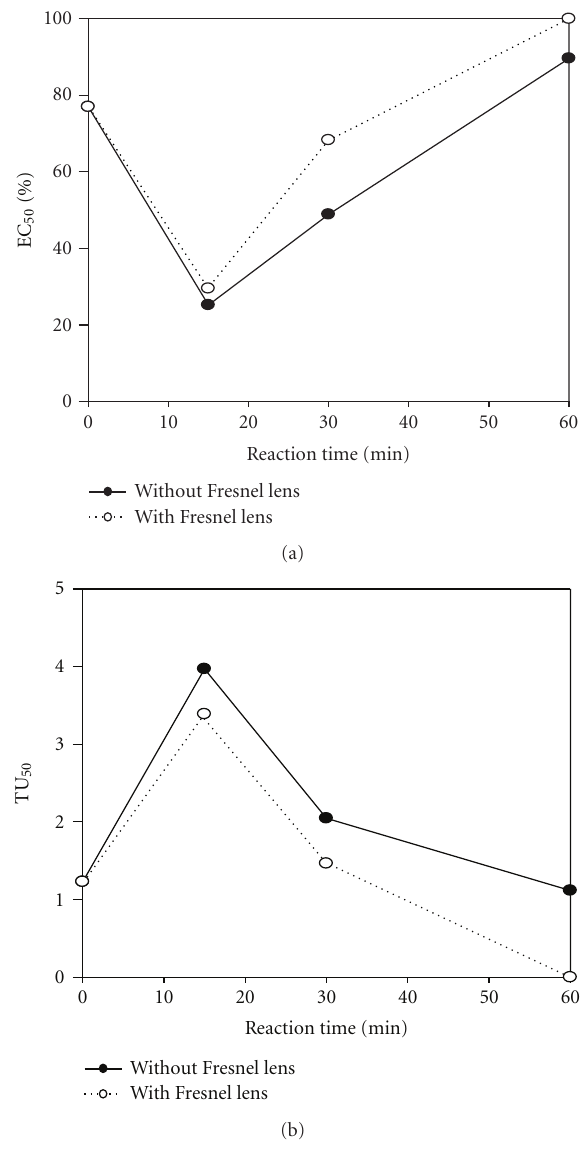
Figure 5: E ff ect of Fresnel lens on the microtoxicity of color filter wastewater in solar photo-Fenton process (initial pH: 5.0; H 2 O 2 /COD = 1.25 g/g; [H 2 O 2 ] 0 /[Fe 2+ ] 0 =